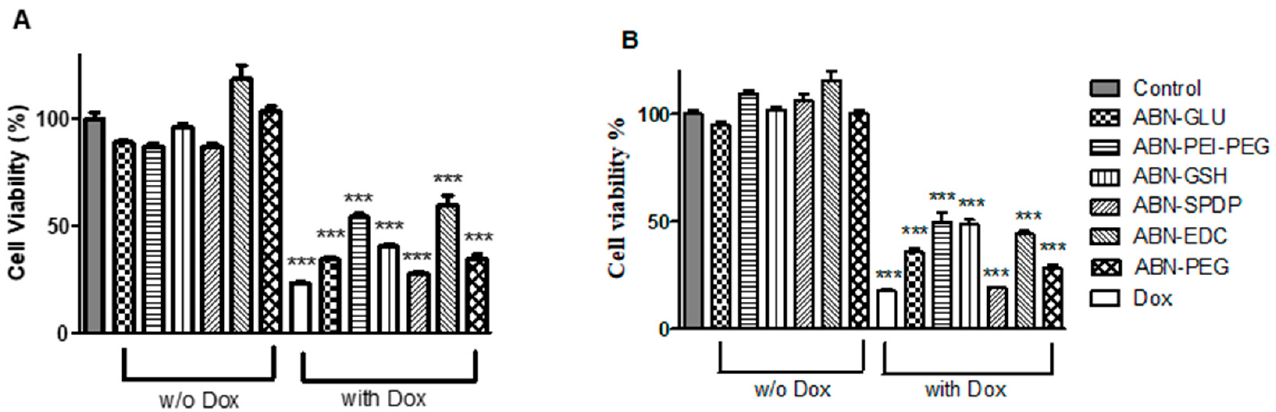
Figure 5. Cell viability assay of Dox-loaded ABNs with different cross-linkers in MCF-7 cells after 48 h ( A ) and 72 h ( B ) of treatment. In all the cases, the concentration of Dox used was 1 µM; 2–6: ABNs without Dox and 8–12: ABNs with Dox. Statistical analysis was performed using one-way ANOVA Tukey’s test. *** p -value < 0.0001.